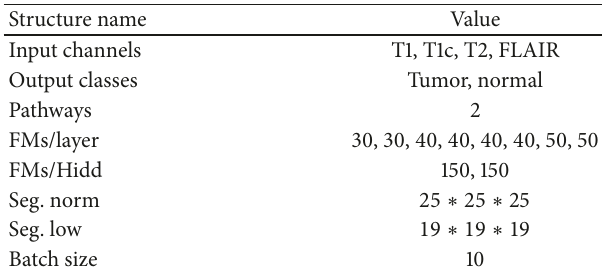
Table 2: Network